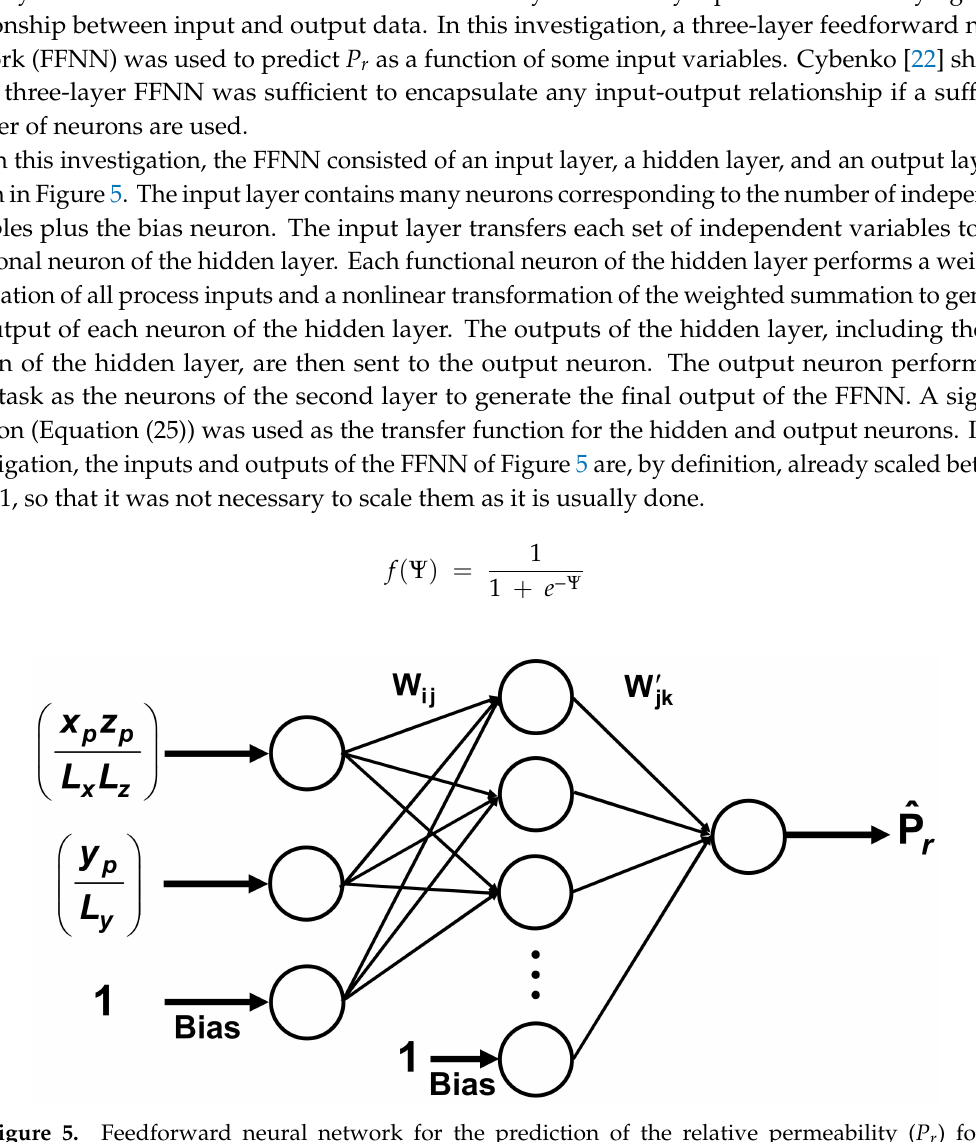
Figure 5. Feedforward neural network for the prediction of the relative permeability ( P r ) for impermeable cuboid nanoparticles as a function of the normalized projected area ( x p z p / L x L z ) and the relative thickness ( y p / L y